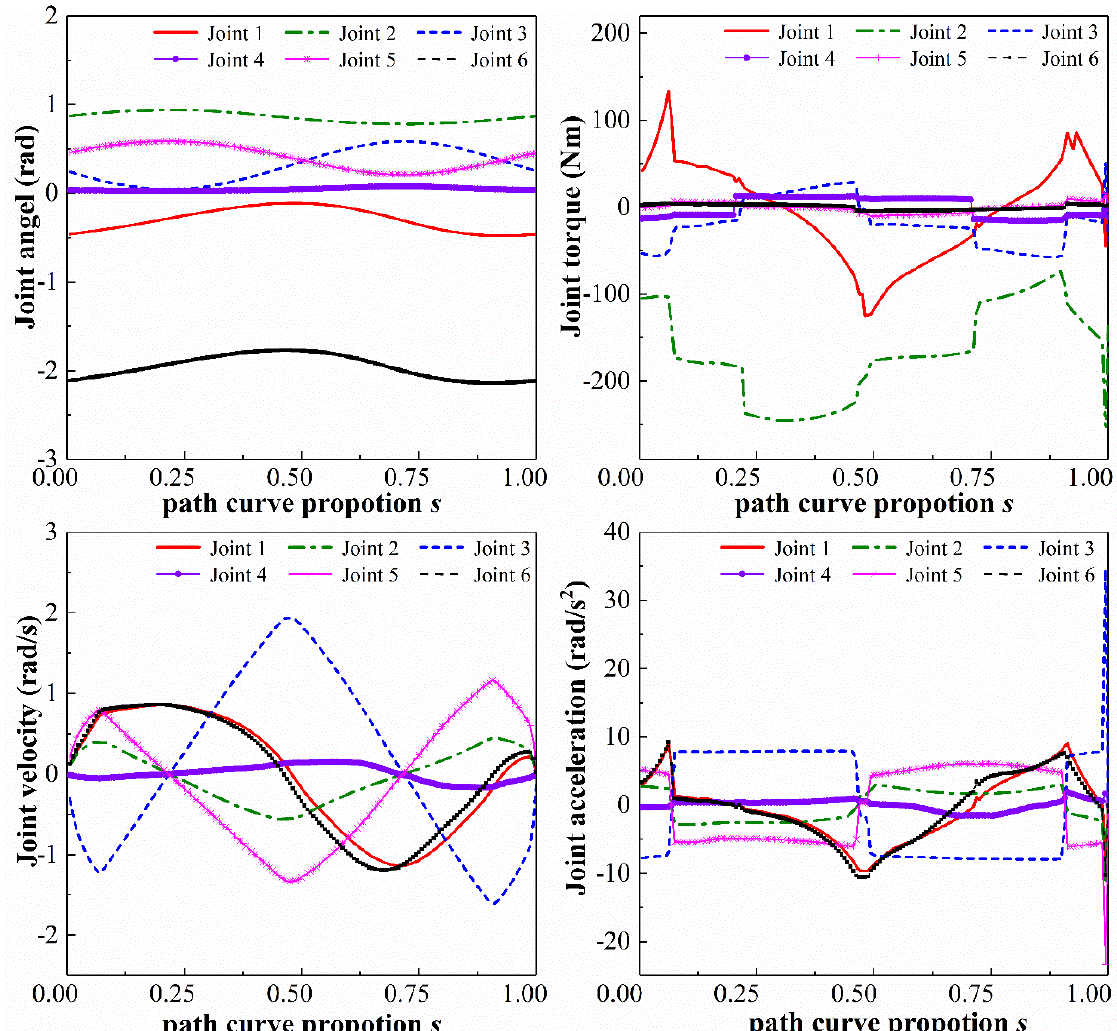
Figure 5. Optimized trajectories for robot joint with the method in reference.